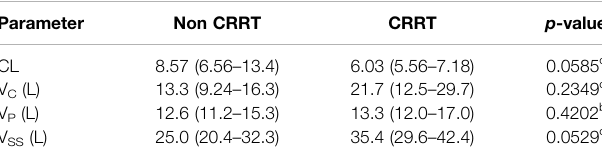
TABLE 3 | Comparison of the fi nal PK parameter estimates between non-CRRT and CRRT groups a .